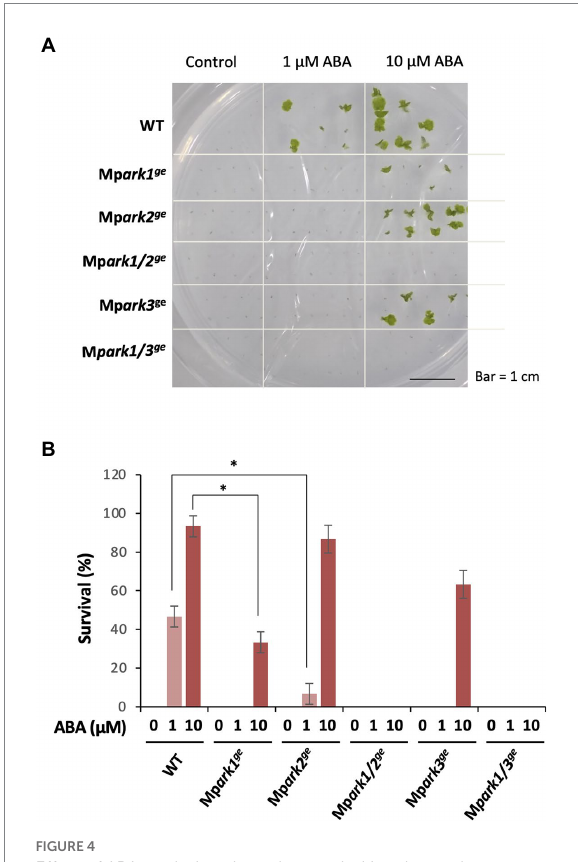
FIGURE 4 Effect of ABA on desiccation tolerance in M. polymorpha. Gemmae of wild type (WT) and the B3-Raf genome-editing lines were cultured for 1 day with or without 1 or 10 μ M ABA in liquid medium. The gemmae were transferred to a container containing silica gel and dried for 2 days. After rehydration, the gemmae were transferred onto a fresh agar medium and cultured for 10 days to determine survival. (A) Growth appearance of gemmalings after culture for 10 days. (B) Survival rate was plotted in histograms. Error bars indicate +/ − SE. * p < 0.05 by t -test ( n =